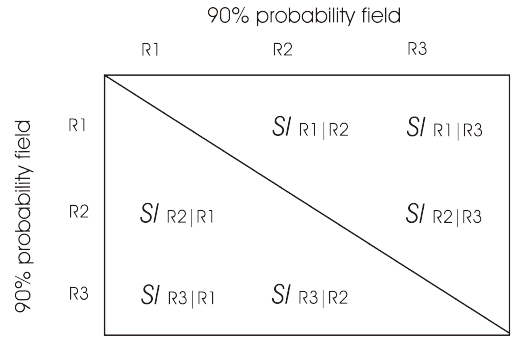
Fig. 2. Cross table showing the number of possible SI cases when comparing three realizations R1, R2 and